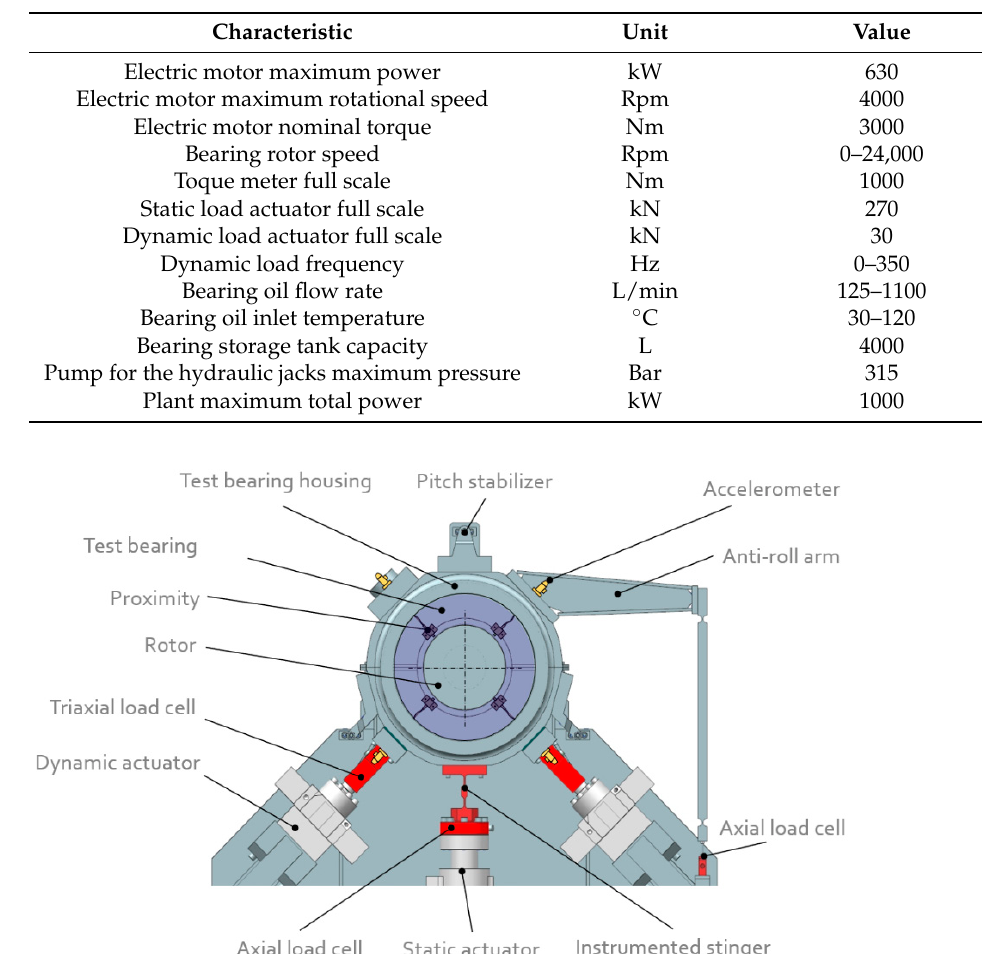
Table 1. Capabilities of the experimental plant.